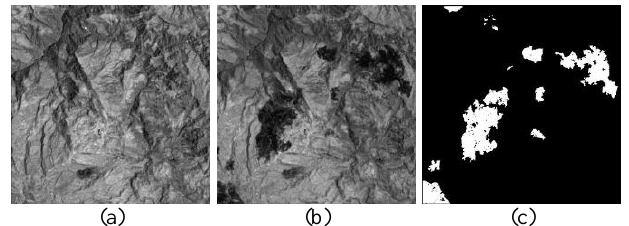
Figure 3. Band 4 of datasets acquired in (a) April 2000 and